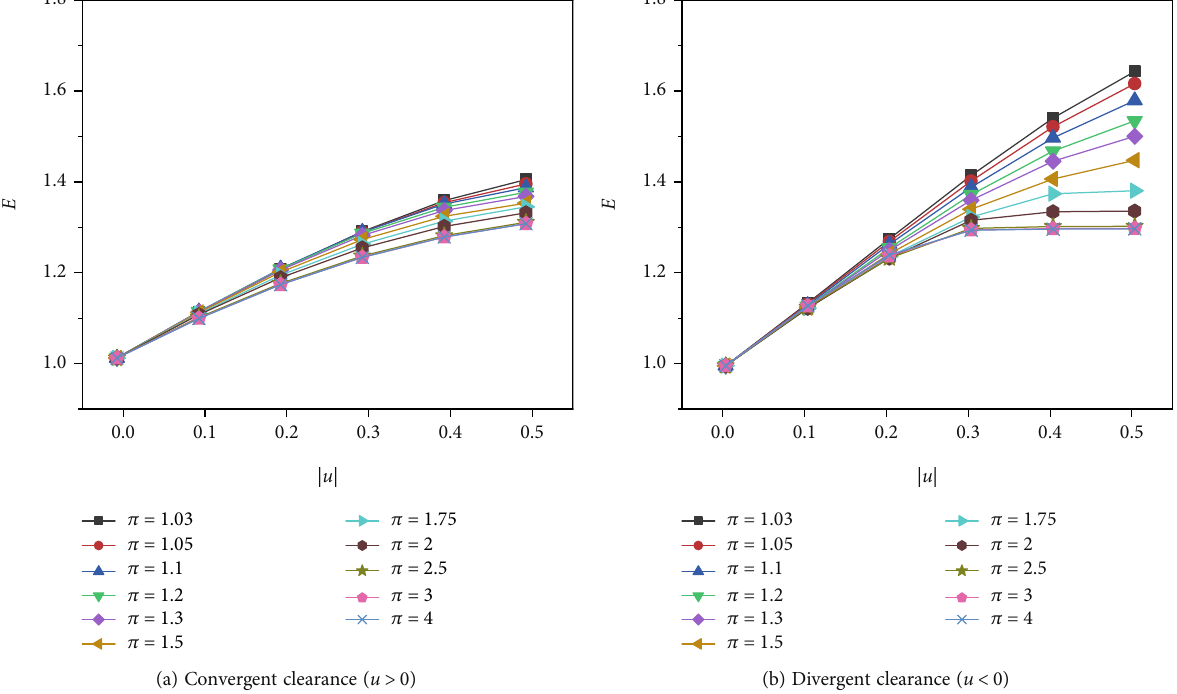
= 0 : 23 , and C = 0 : 067 U